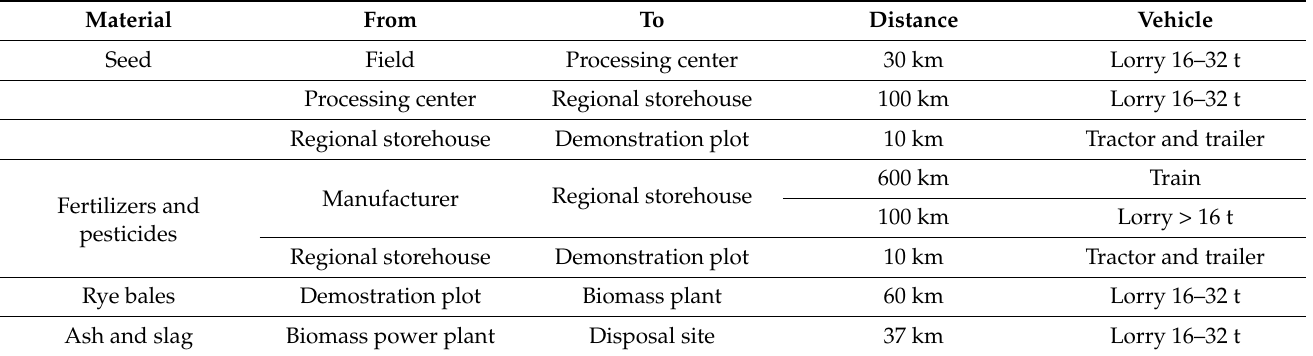
Table 4. Transport system